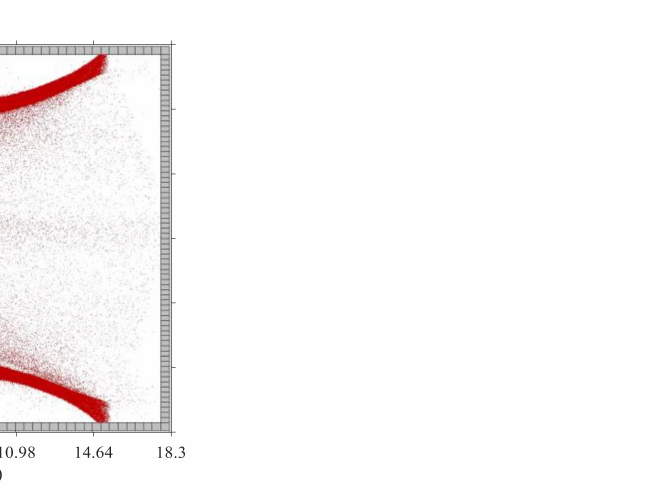
Figure 4. The filtering effect of the magnetic field on the electron beam with a temperature of 10 eV on the X − Z plane at 15 µ s.